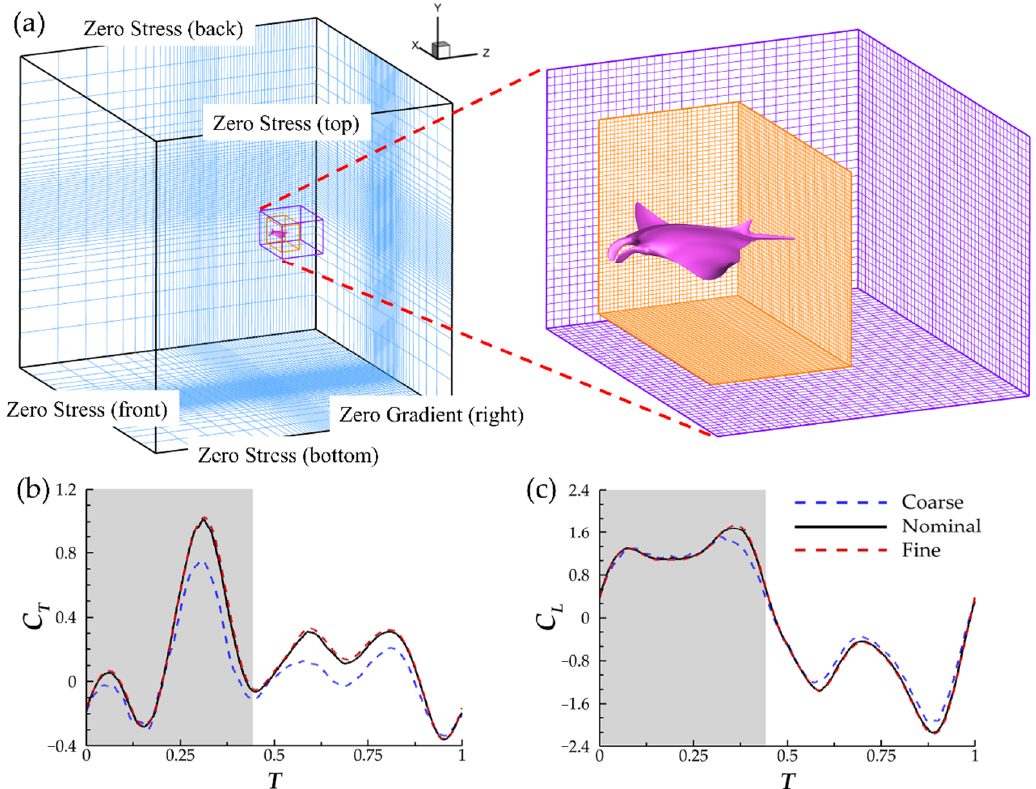
Figure 4. ( a ) Schematic of the computational domain and boundary conditions used in the present study. ( b ) Instantaneous thrust and ( c ) lift comparison between the coarse mesh (∆ = 0.018 BL, ~4.3 million nodes) nominal mesh (∆ = 0.0085 BL, ~8.7 million nodes), and fine mesh (∆ = 0.0065 BL, ~15.4 ~4.3 million nodes) nominal mesh ( ∆ = 0.0085 BL, ~8.7 million nodes), and fine mesh ( ∆ = 0.0065 BL, million nodes). ~15.4 million